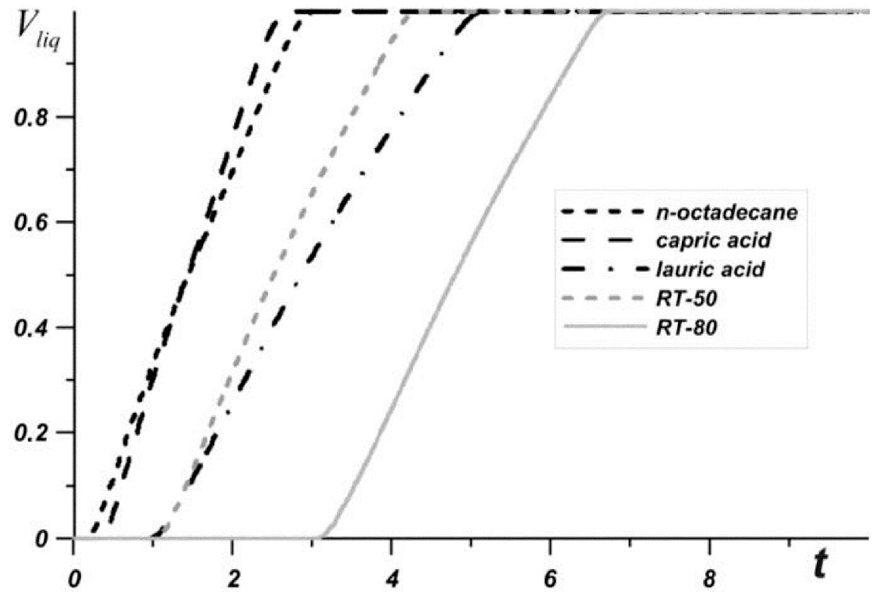
Figure 12. Liquid volume fraction over time for the different PCMs tested by Bondareva et al. (Cop- yright 2020 Bondareva et al. https://creativecommons.org/licenses/by/4.0/legalcode) Accessed on 18 June 2021 [80].